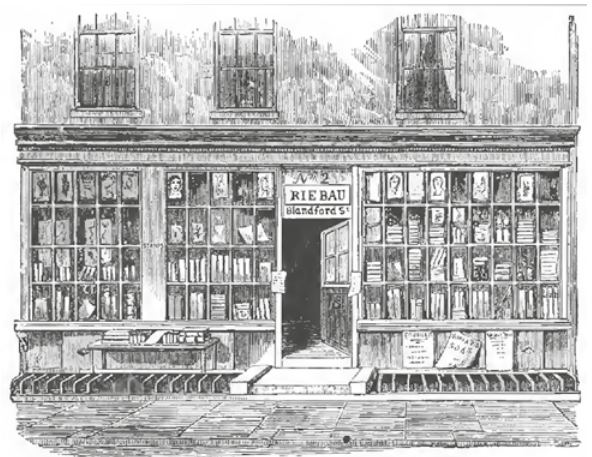
Figure 1. The bookshop of Mr. Riebau in London [2].